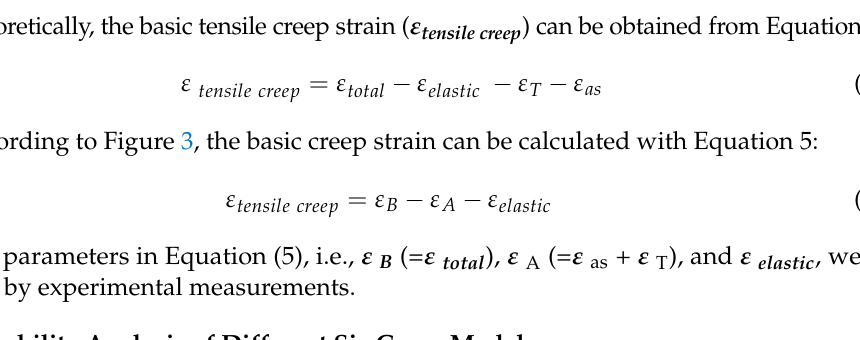
Theoretically, the basic tensile creep strain ( ε tensile creep ) can be obtained from Equation 4: